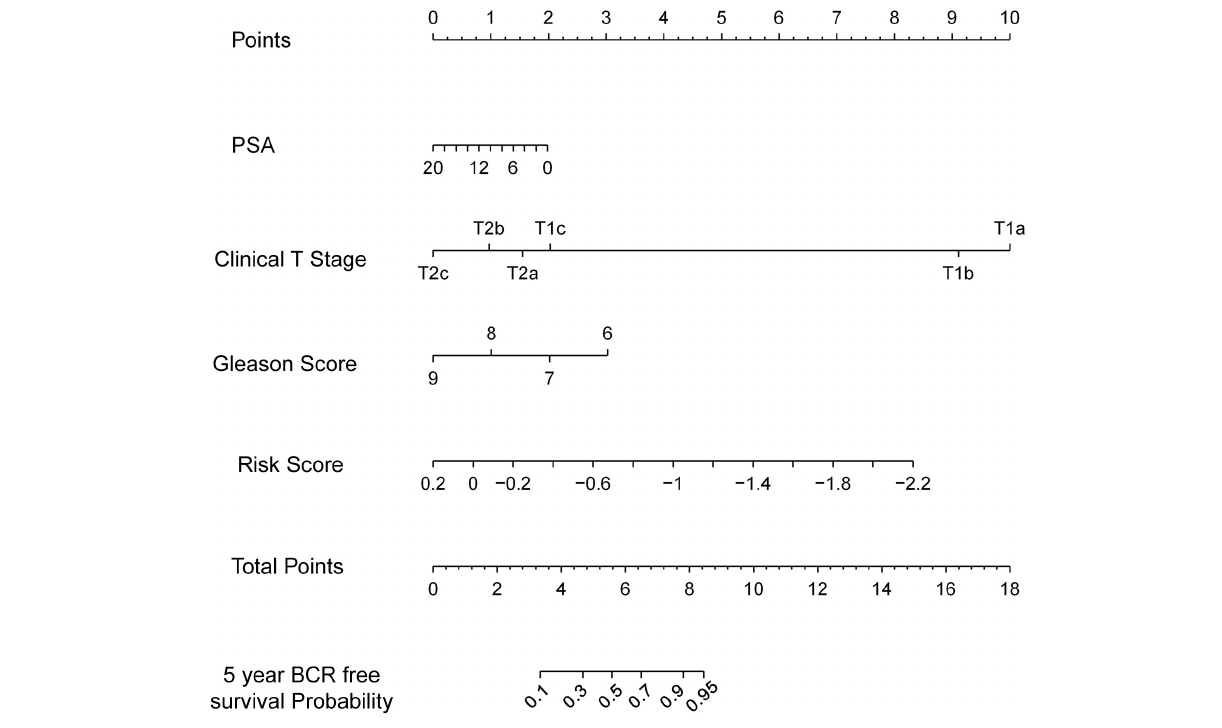
FIGURE 4 | The nomogram to predict likelihood of 5-year BCR-free survival. Nomogram predicting PCa patients’ 5-year BCR-free survival. Each variable is projected to the point scale to obtain a value. The higher the value, the more likely to have